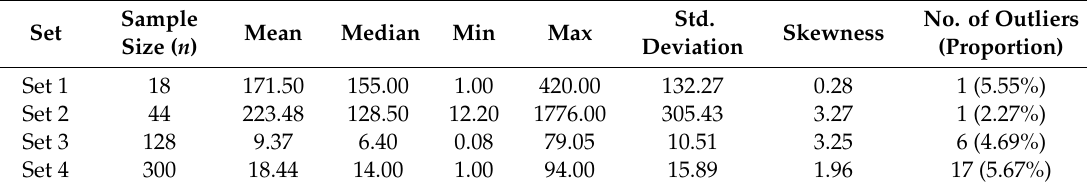
Table 9. Descriptive statistics for data Sets 1, 2, 3 and 4.